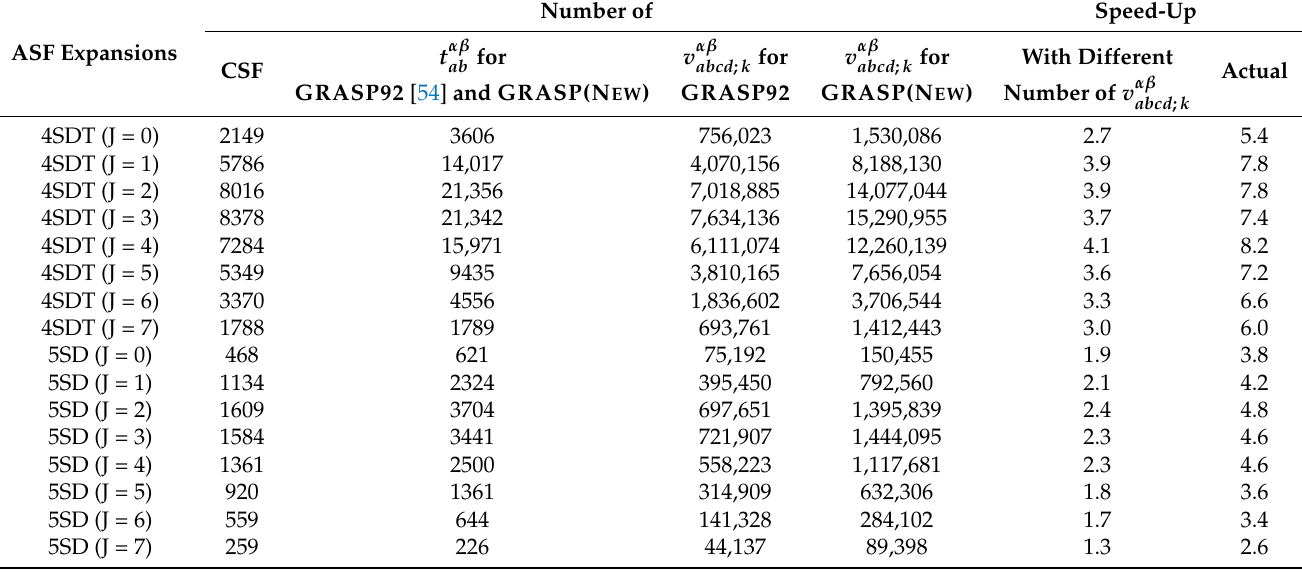
Table 6. A speed-up of GRASP(N EW ) [22,35] as compared with GRASP92